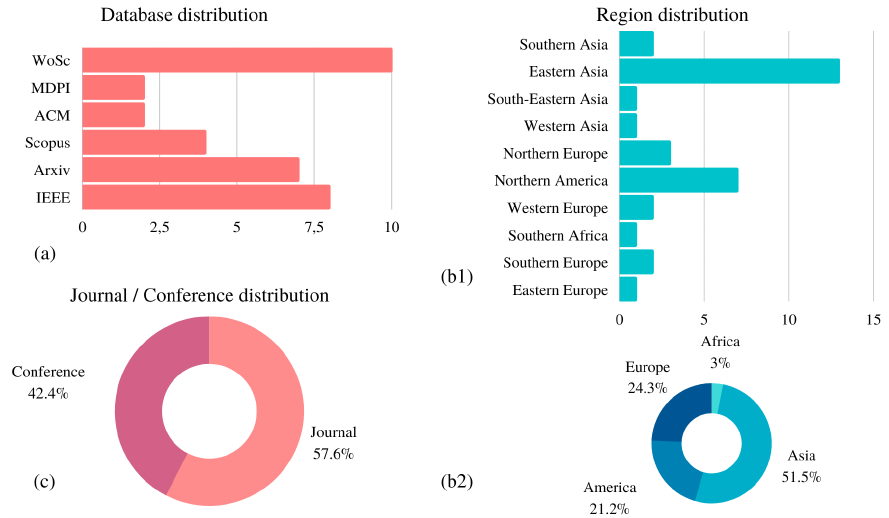
Figure 2. Frequency of research database, conference or journal and by geographical distribution of publication. ( a ) is the distribution of the different databases from which we collected papers in this study. ( b1 , b2 ) represent respectively the distribution of the selected papers by region and by continent. ( c ) the distribution of papers by conference and journal.